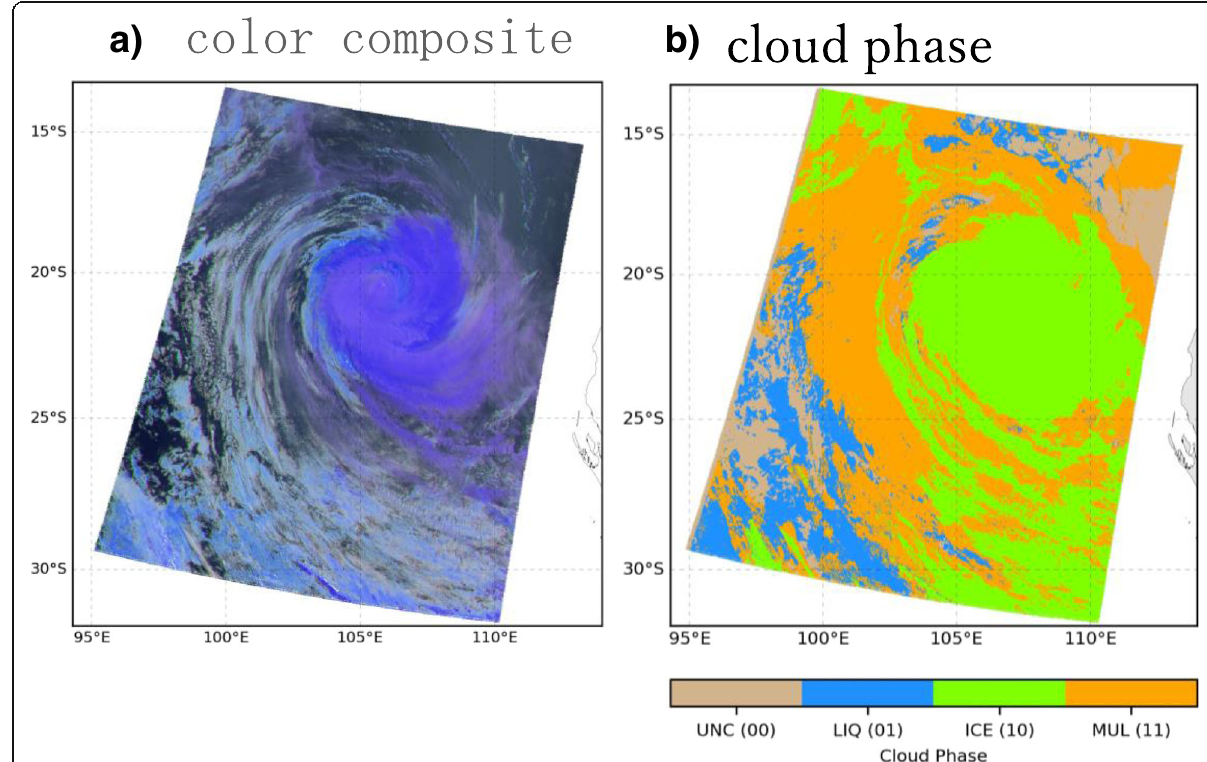
Fig. 6 Images of a ) the color composite of the SW4, SW3, and SW1 channels and b ) the cloud phase flag discriminated by the SGLI cloud phase algorithm. The images were composed from the GCOM-C/SGLI observation over the Indian Ocean on March 23, 2018, which captured Tropical Cyclone